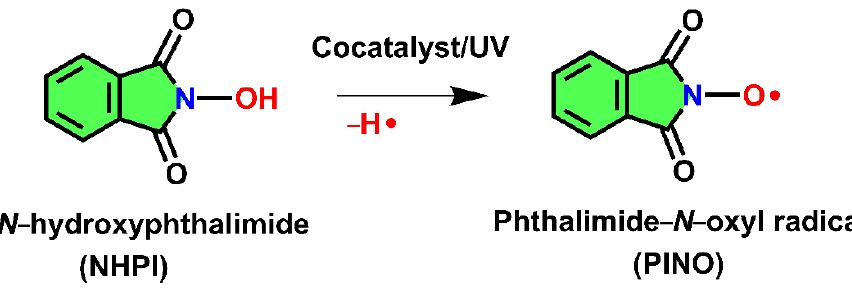
Figure 1. The schematization of the generation of the PINO radical. In the field of polysaccharides, the first report on the use of the PINO radical (in situ generated from NHPI) was for cellulose oxidation [12]. Most of these methods of oxidation require an appropriate cocatalyst and the additional presence of sodium hypochlorite and sodium bromide in the system for the PINO radical generation [4,9,12–16]. Other re- search employed sodium bromide/copper(II) salts [17], anthraquinone/O 2 [18], or sodium hypochlorite/sodium bromide in a cocatalyst-free system to generate PINO radicals [11,19]. Regardless of the mode of the PINO radical generation, the oxidation takes place selectively at the level of the primary hydroxyl groups of the polysaccharides with the formation of the carboxylic groups. Degumming, the procedure of removing non-cellulosic content from threads such as lignin, hemicellulose, pectin, and other wood elements, is critical to the industrial processing used to separate cellulosic fibers. In an effort to reduce energy consumption, the use of hazardous and expensive solvents, and other factors, researchers are continuously focusing on this crucial process. Due to its high efficiency and energy savings under these circumstances, oxidative degumming has caught the interest of many studies [20]. Under the alkaline degumming with H 2 O 2 approach, researchers added H 2 O 2 gradually, attempting to minimize the harm caused by severe H 2 O 2 oxidation to cellulose in alkaline circumstances [21]. However, H 2 O 2 ’s intense oxidation inexorably resulted in the depolymerization of cellulose, harming the fiber. A suggested remedy was the TEMPO system for selective oxidation degumming of ramie [22]. The mechanical qualities of fibers degummed by TEMPO-H 2 O 2 were superior to those of fibers degummed only by the H 2 O 2 degumming method because only the primary hydroxyl group at the C6 position of cellulose was selectively oxidized during this process. How- ever, the TEMPO system ’ s oxidant is NaClO, a chlorine-containing reagent that must be replenished. European and worldwide environmental law is becoming more stringent, recognizing the rising need for halogenated compound substitution at the producing and end-user levels. In a very recent proposed strategy for cellulose degumming, H 2 O 2 is used in tandem with a catalyst ( N -hydroxyphthalimide) and a cocatalyst (antraquinone) at pH